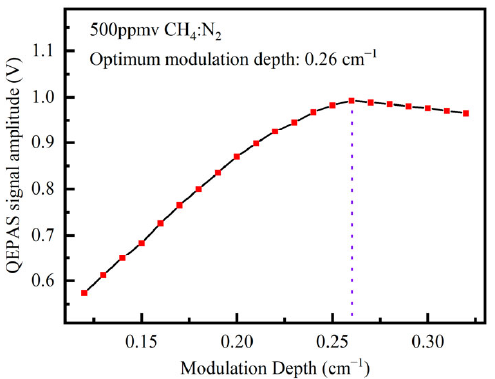
Figure 3. The amplitude of the 2 f photoacoustic signal relative to the modulation depth of the laser.